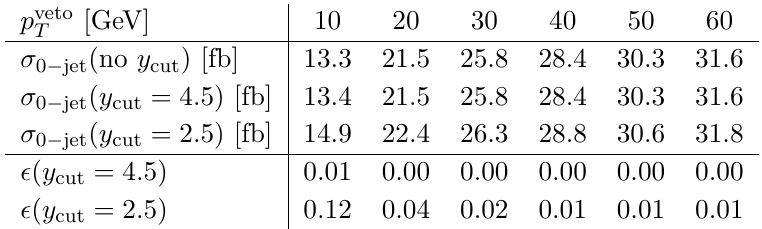
Table 8 . The ZZ + 0 -jet cross-section at NNLO ( µ = Q ), with and without a jet rapidity